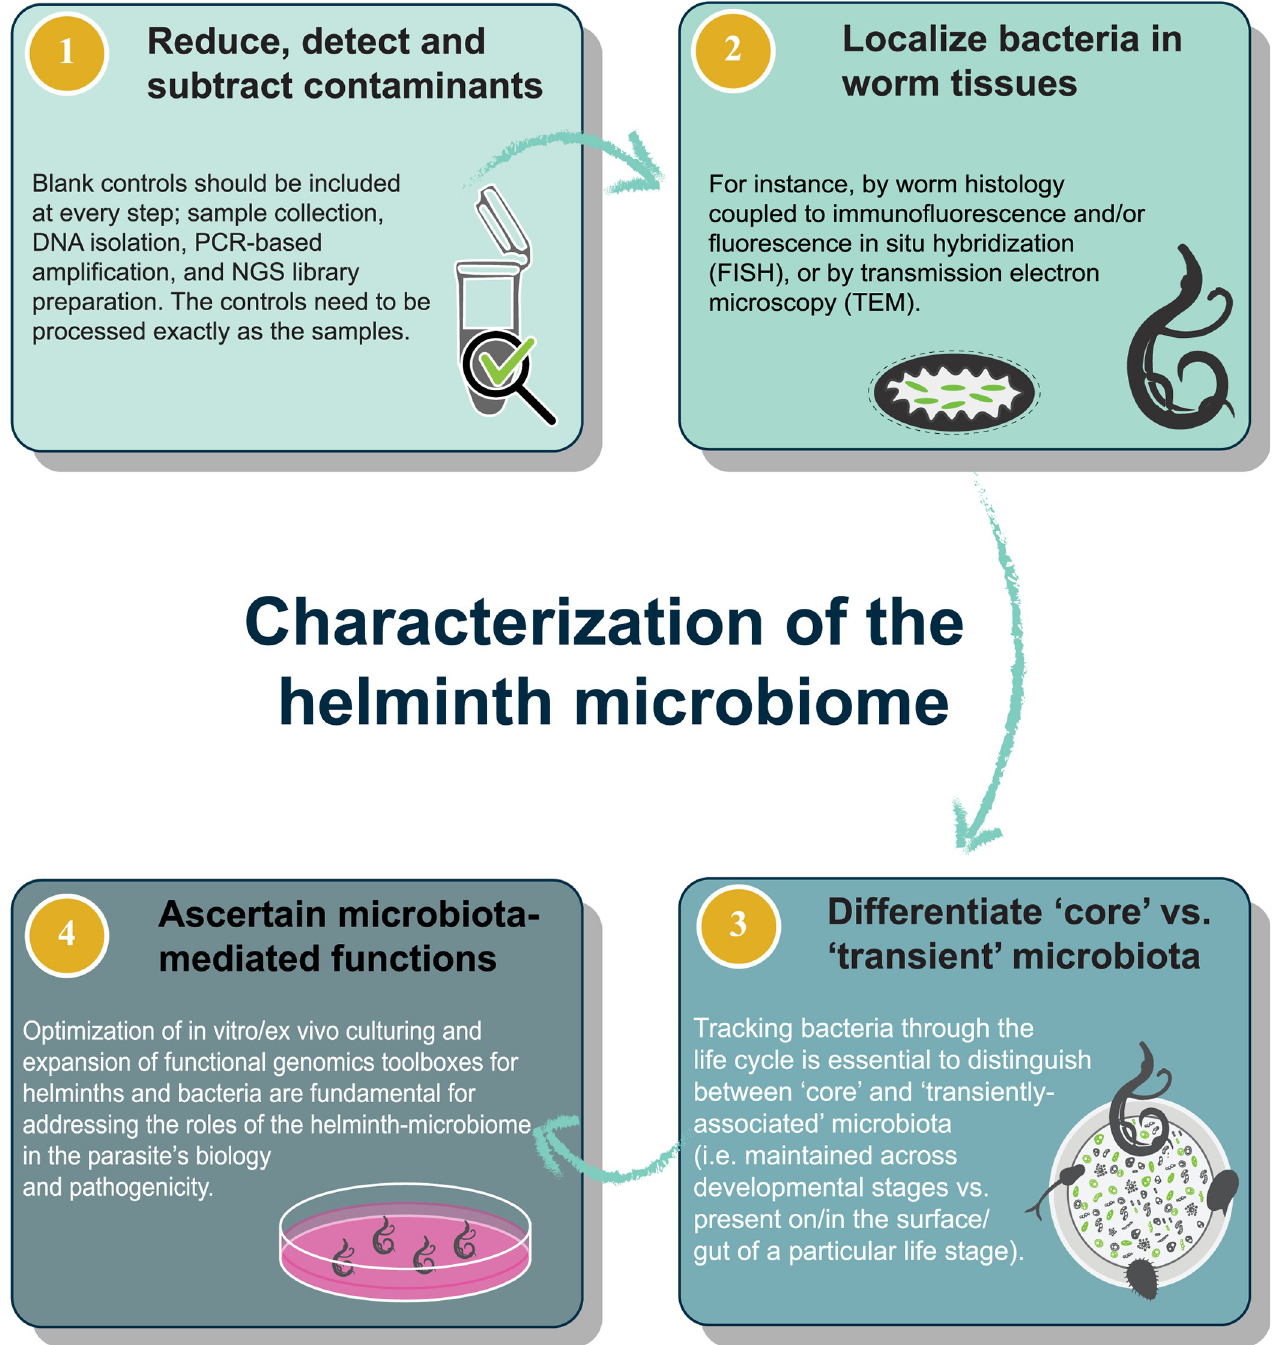
Fig 1. Key elements for a reliable and reproducible characterization of the helminth-associated microbiome. NGS; next generation